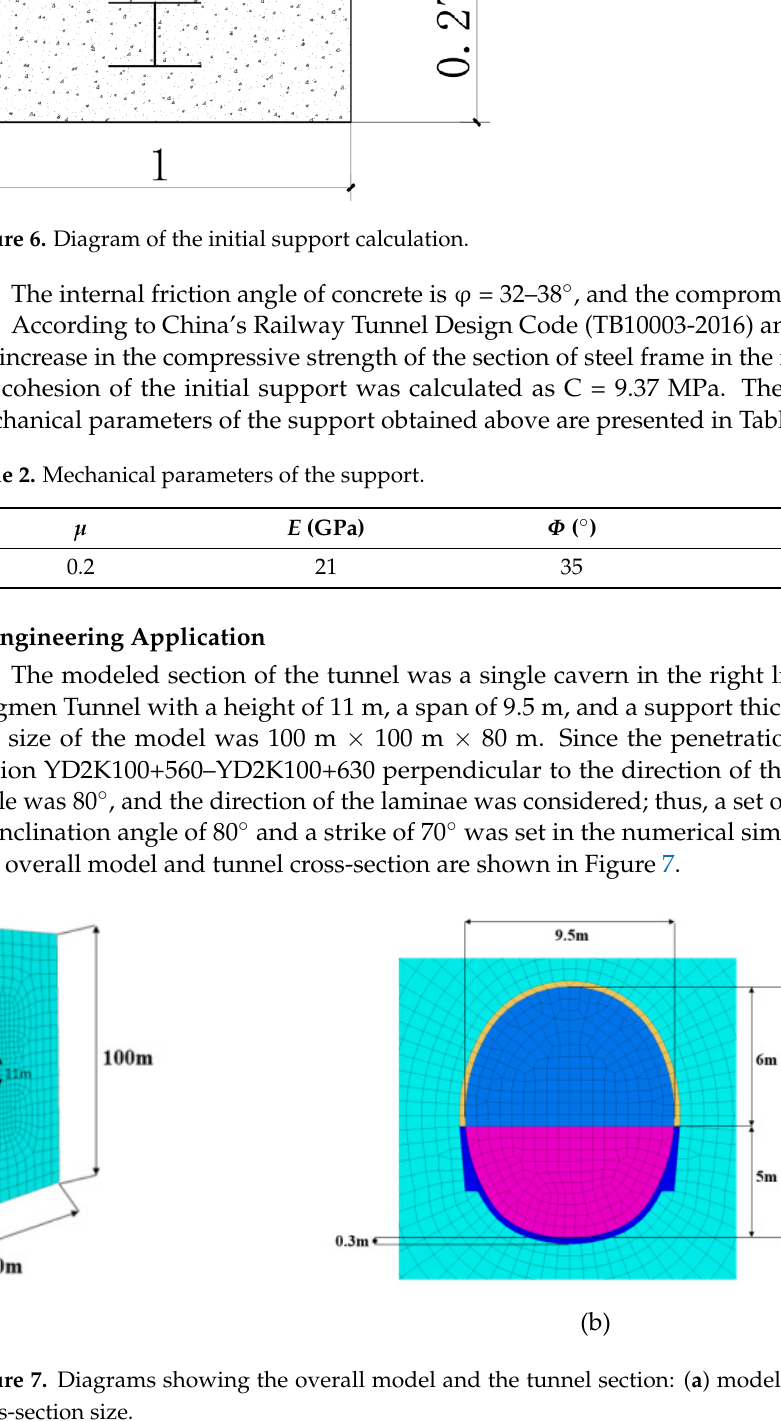
(b) Figure 8. Photos of two stages of the excavation at the site: ( a ) #58 right tunnel working face; ( b ) #59 right tunnel working face. In the numerical simulation, the position of the penetration working face was set as y = 0 m in the section. The section deformation data was obtained from the exit side of the bottom bench, i.e., y = 3 m (construction entrance side) and y = − 3 m (construction exit side). The schematic diagram of the simulated excavation is shown in Figure 9. Figure 9. Schematic diagram of simulated excavation sequence.